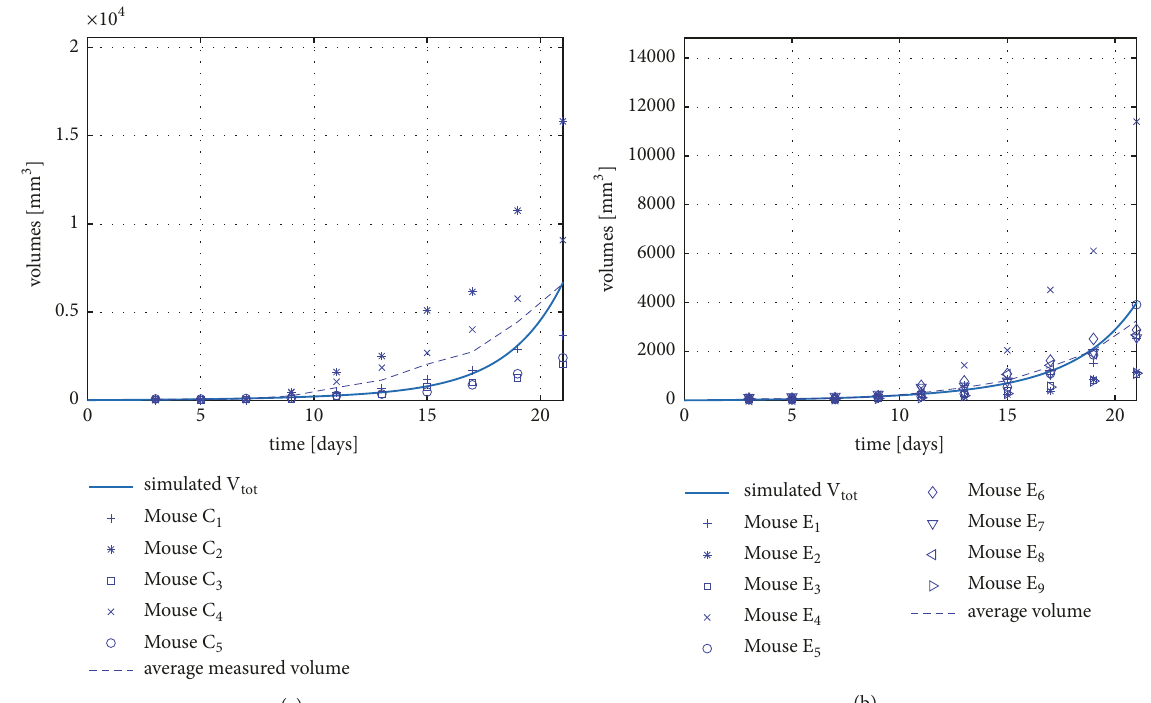
Figure 3: Measured and simulated tumor volumes in the case of therapy 1 (a) and therapy 2